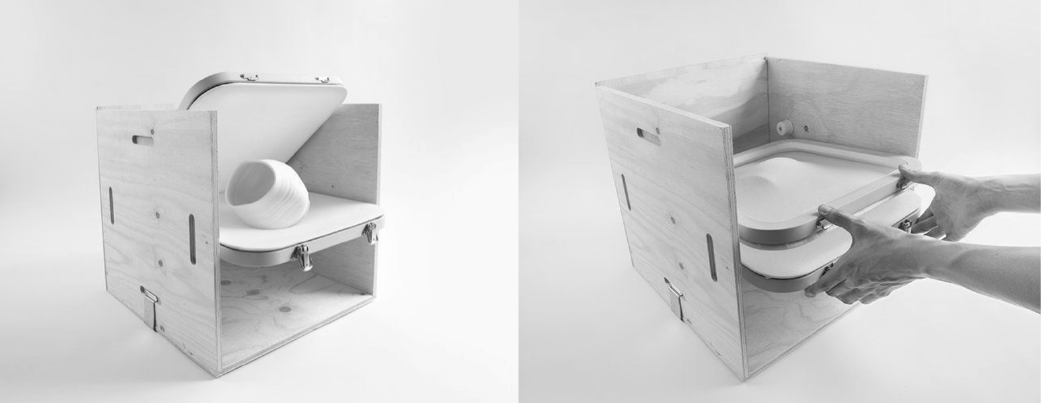
Figure 4. Existing system of frame-membrane packing “Fragile” by Mireia Gordi Vila. [51–53].